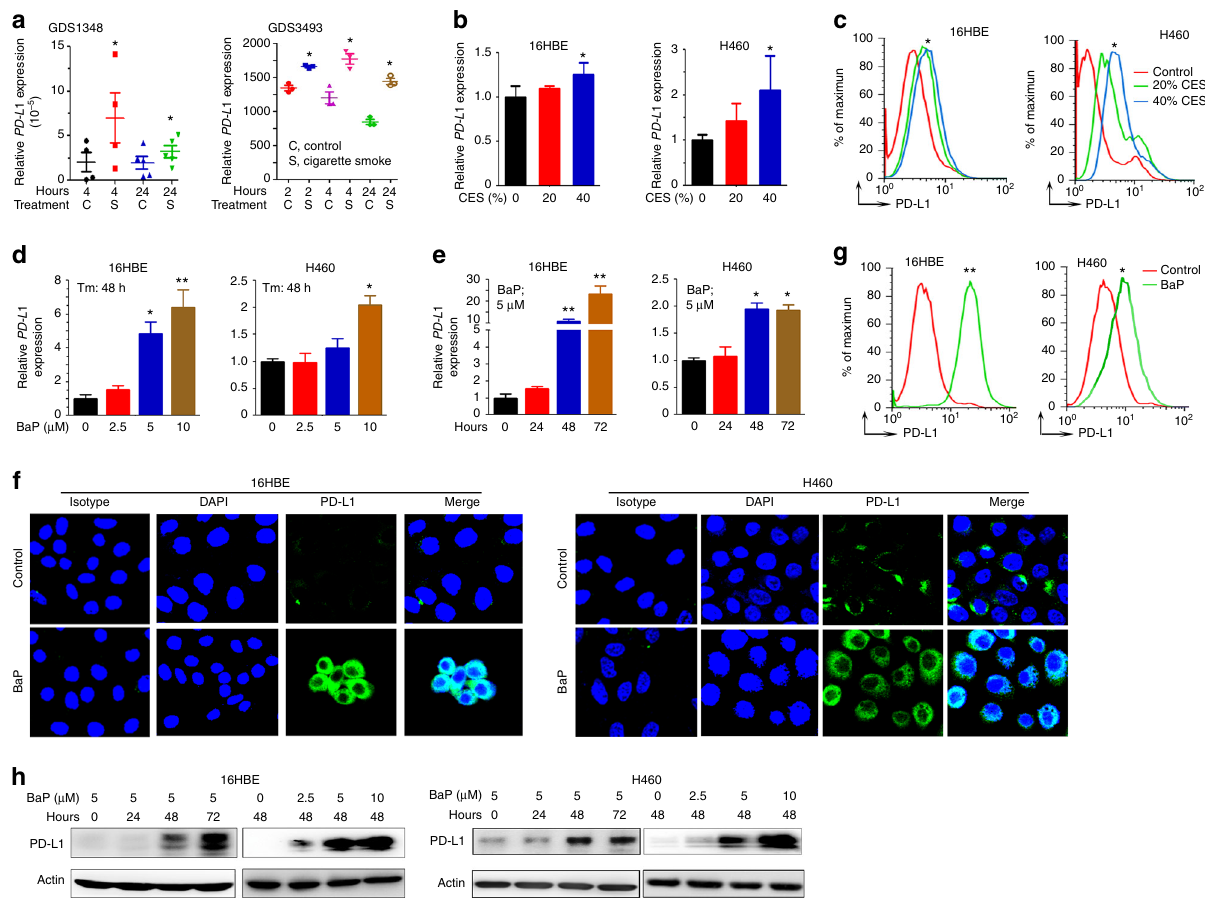
Fig. 1 Tobacco smoke and carcinogen BaP induces PD-L1 expression on lung epithelial cells. a In microarray datasets of gene expression pro fi les of normal bronchial epithelial cells exposed to cigarette smoke, the expression of PD-L1 was analyzed. C, control; S, cigarette smoke. Error bars, sd. b , c The cells were treated with cigarette smoke extract (CES) at indicated concentrations for 48 h, and the expression of PD-L1 was assessed by real-time RT-PCR ( b ) and fl ow cytometry ( c ). The experiments were conducted in triplicate and repeated for three times. Error bars, sd. d – h The cells were treated with BaP at indicated concentrations for indicated time points, and the expression of PD-L1 was assessed by real-time RT-PCR ( d , e ), immuno fl uorescence assays ( f ), fl ow cytometry ( g ), and western blot ( h ) assays. Student ’ s t test, * P < 0.05; ** P < 0.01. Error bars,